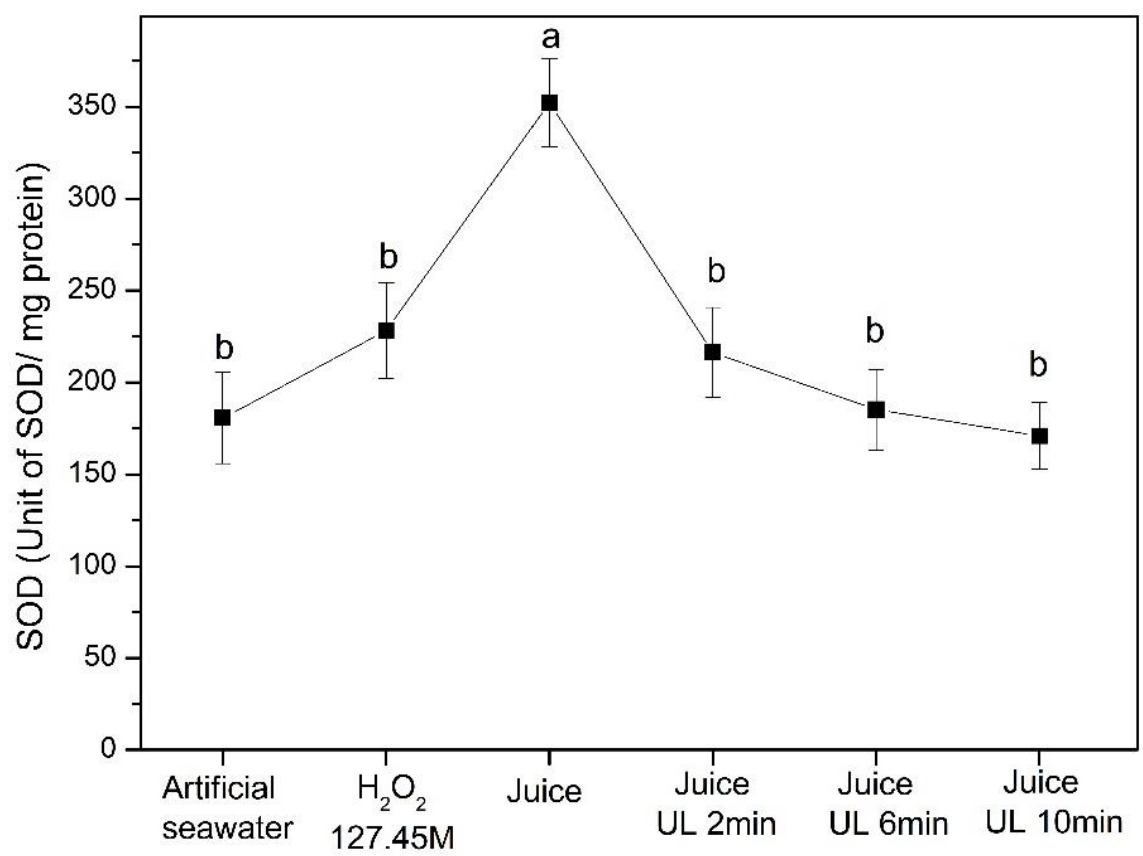
Figure 10. Superoxide dismutase (SOD) activity in response to 72 h of H 2 O 2 exposure of Artemia salina nauplii on unprocessed sapota-do-Solimões juice and processed by ultrasound (0 to 10 min). The different letters indicate statistically significant differences ( p ≤ 0.05).